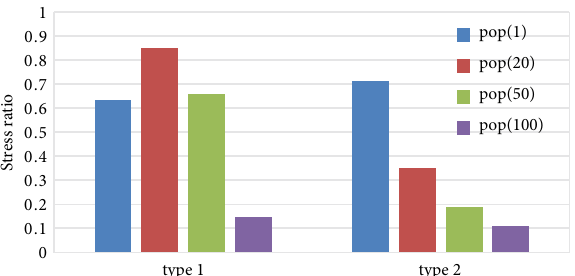
Fig. 6. Stress ratio of the first model columns groups